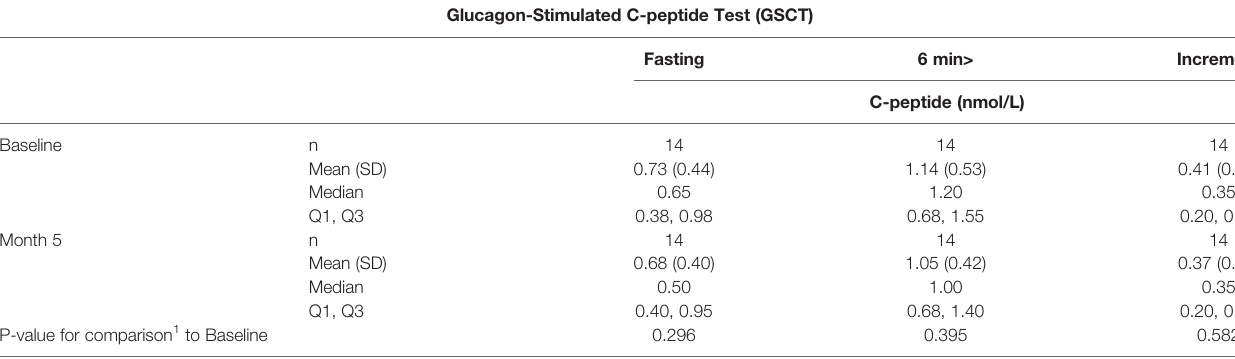
TABLE 4 | Insulin secretion capacity at Baseline and Month 5 assessed by